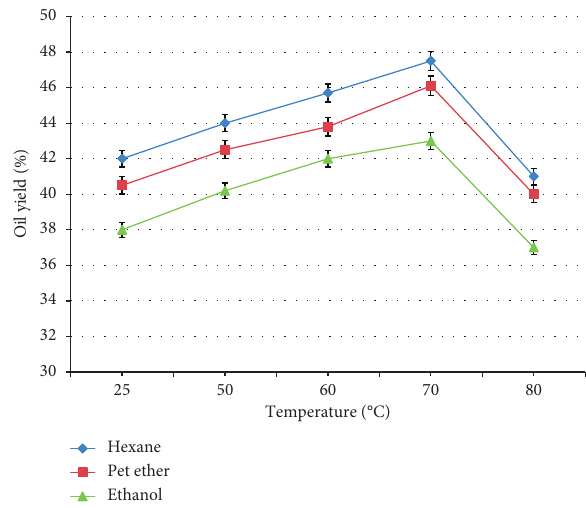
Figure 2: Effect of extraction temperature on oil recovery; ex- traction time